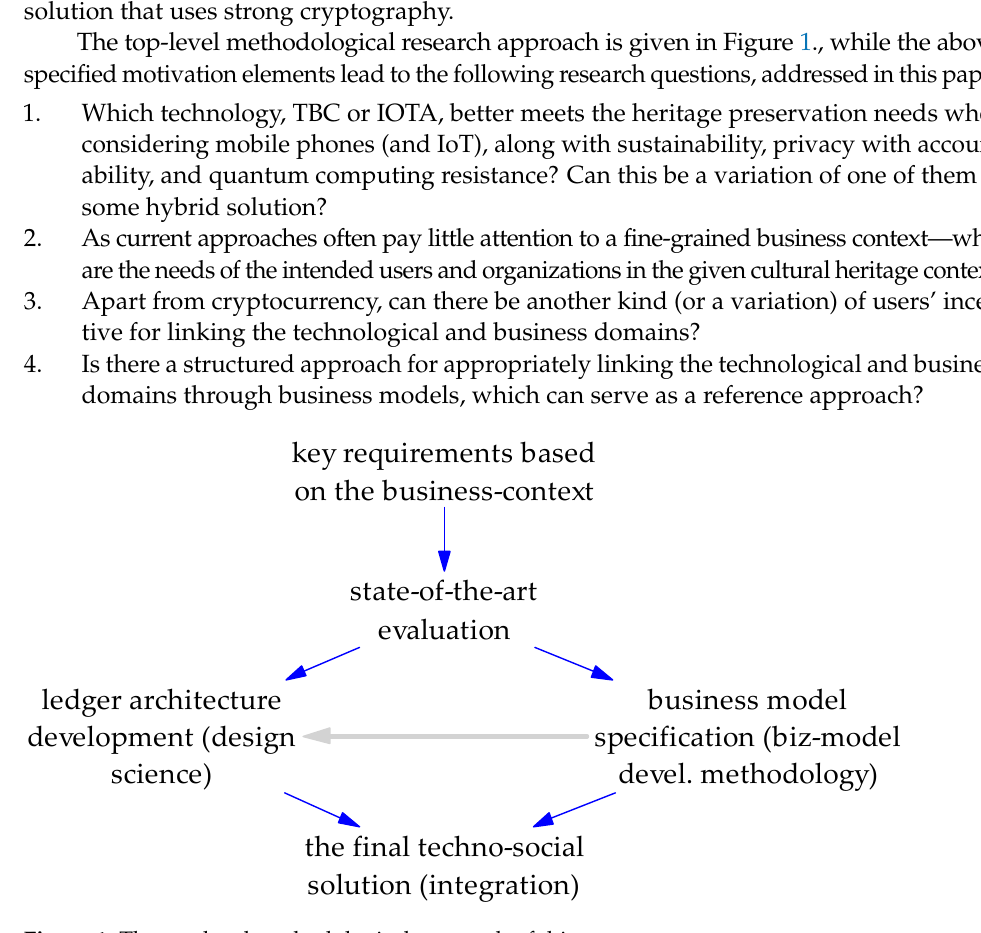
Figure 1. The top-level methodological approach of this paper.